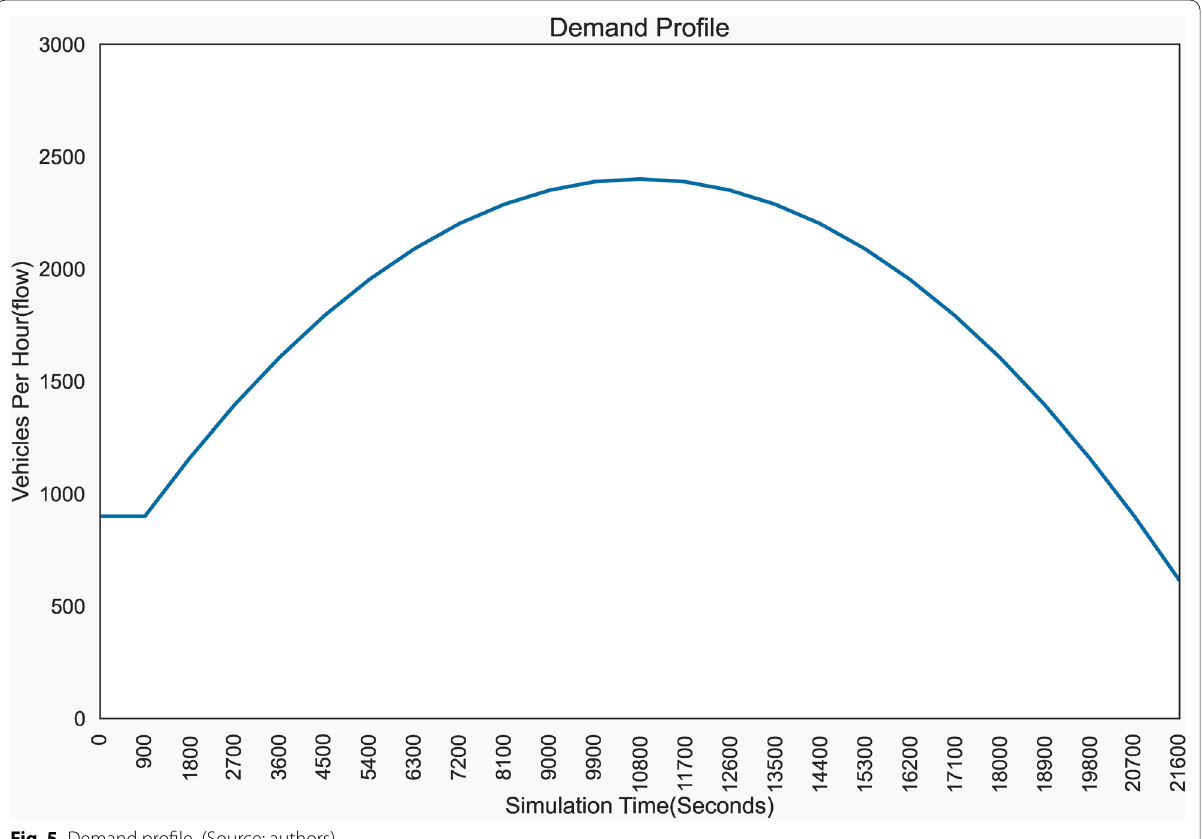
Fig. 5 Demand profile (Source: